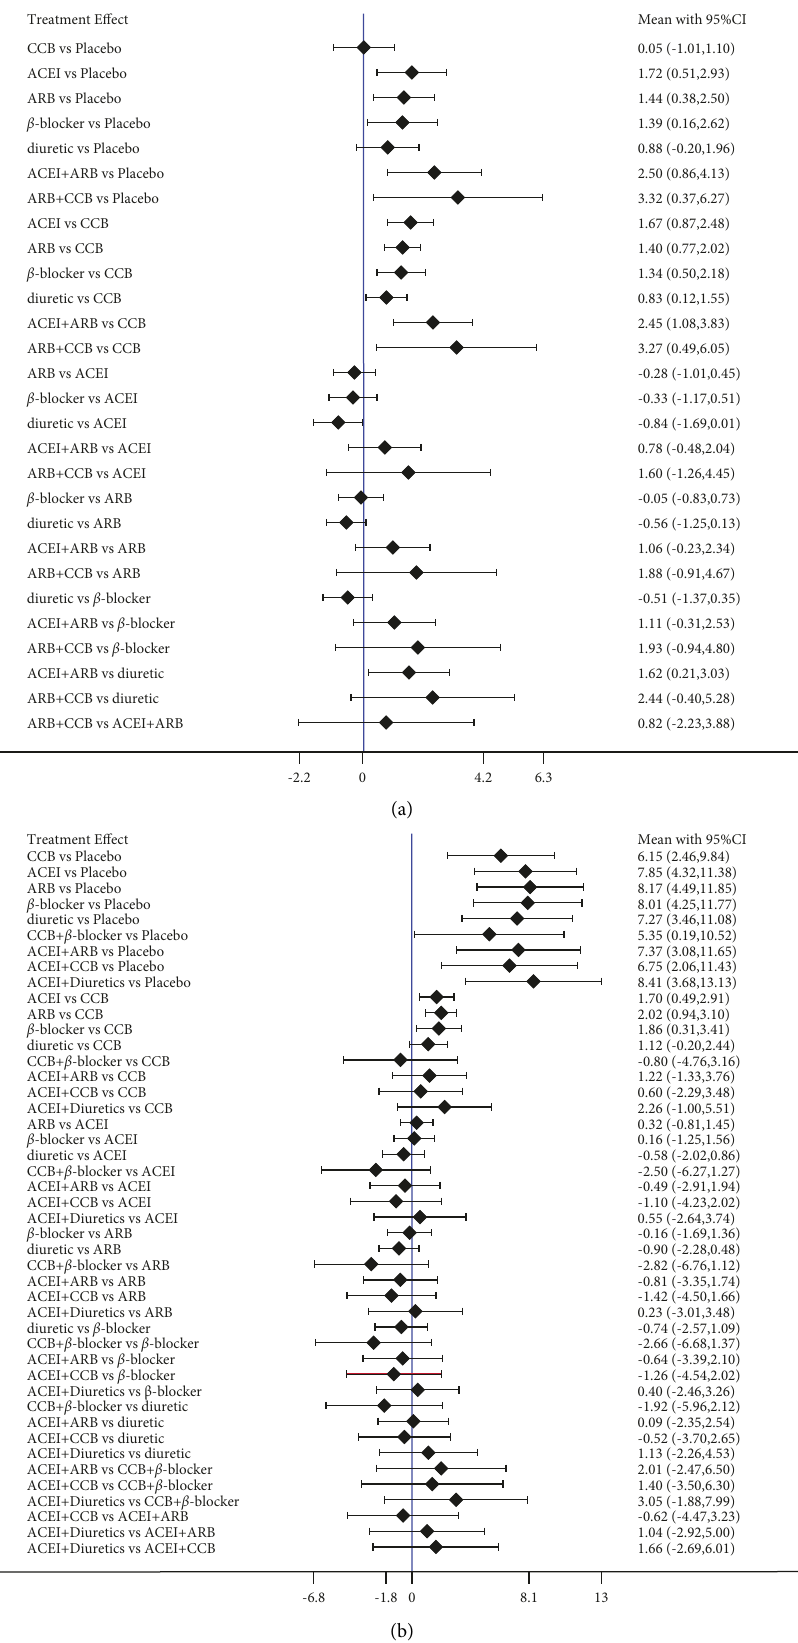
Figure 9: Subgroup analysis of forest plots for the assessment of duration treatments in FMD. (a) Duration treatments ≤ 8 weeks, (b) duration treatments ＞ 8 weeks). ACEI: angiotensin-converting enzyme inhibitors, ARB: angiotensin receptor blocker, CCB: calcium channel